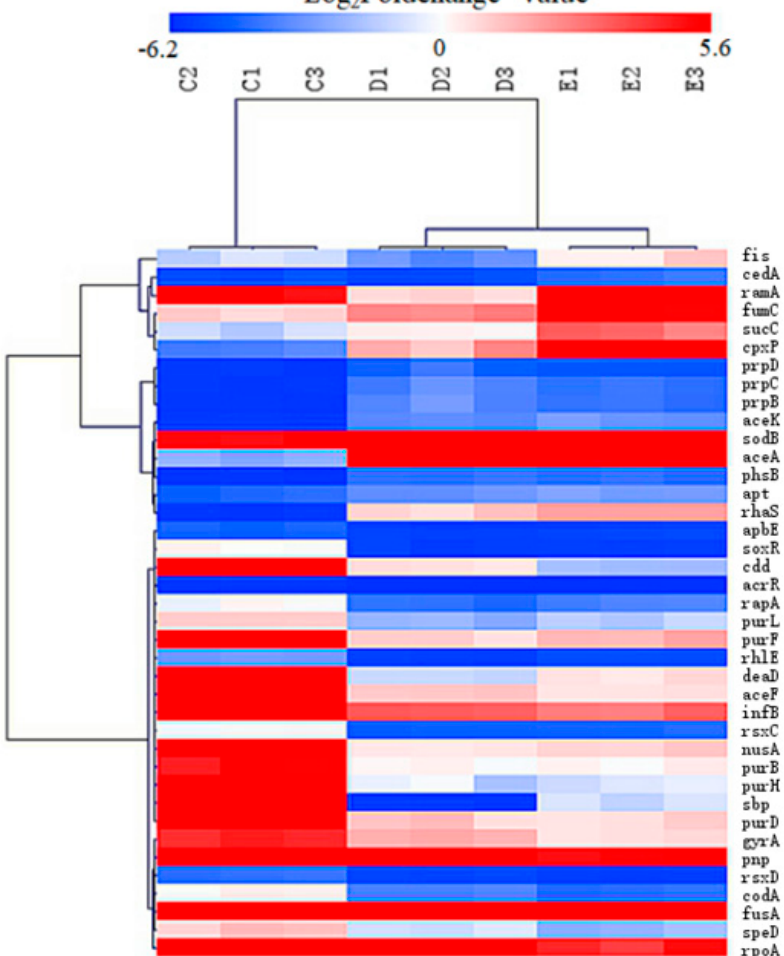
Figure 5. Heatmap of the candidate key genes involved in the sub-MIC induced ENR resistance in S. Enteritidis. “C 1 , C 2 , C 3 ”, “D 1 , D 2 , D 3 ”, “E 1 , E 2 , E 3 ” represent triplicate of mutants 32M (1/2M), 16M (1/32M) and 8M (1/128M); “red colour” represents gene up-regulation, “blue colour” represents gene down-regulation, and the shade of the color indicates the degree of gene expression. The 573 co-DEGs were blasted in the CARD database, and the results showed that there were 19 known drug resistance genes (Table 3). Table 3. Resistance-related DEGs blasted in the CARD.